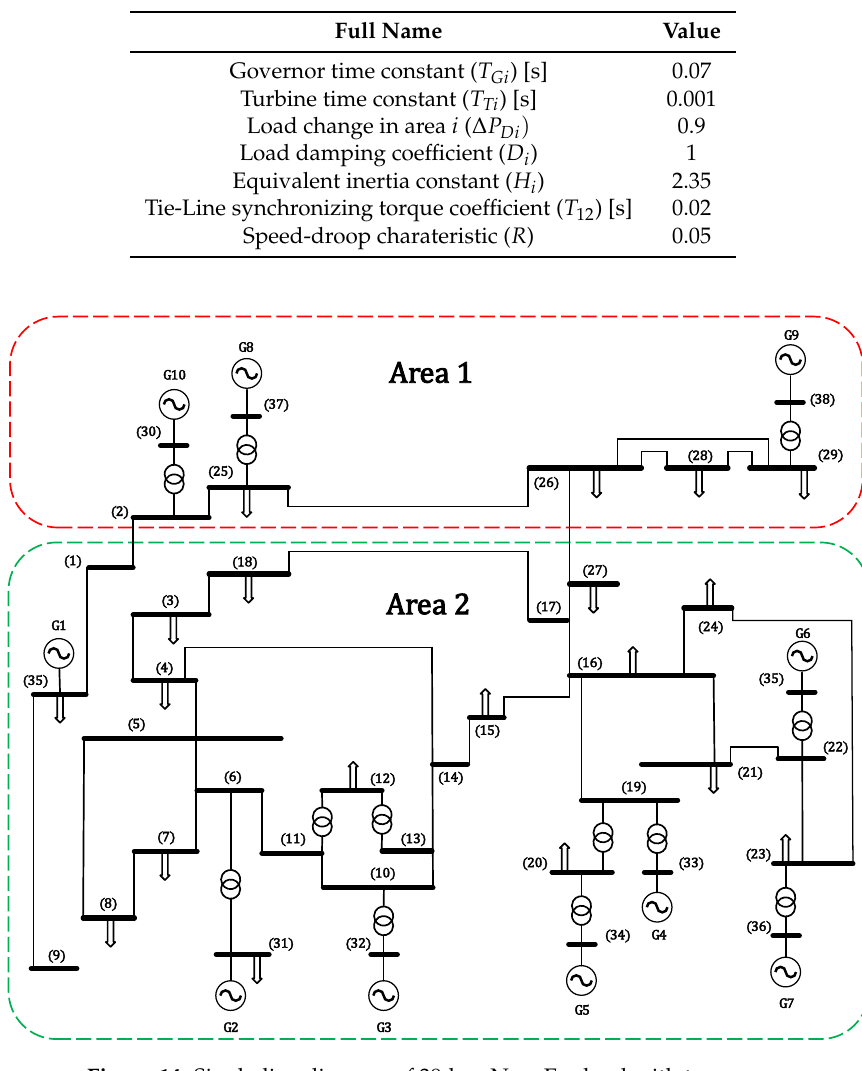
Table 2. Parameters of control area i = 1,2 for 39-bus test system.